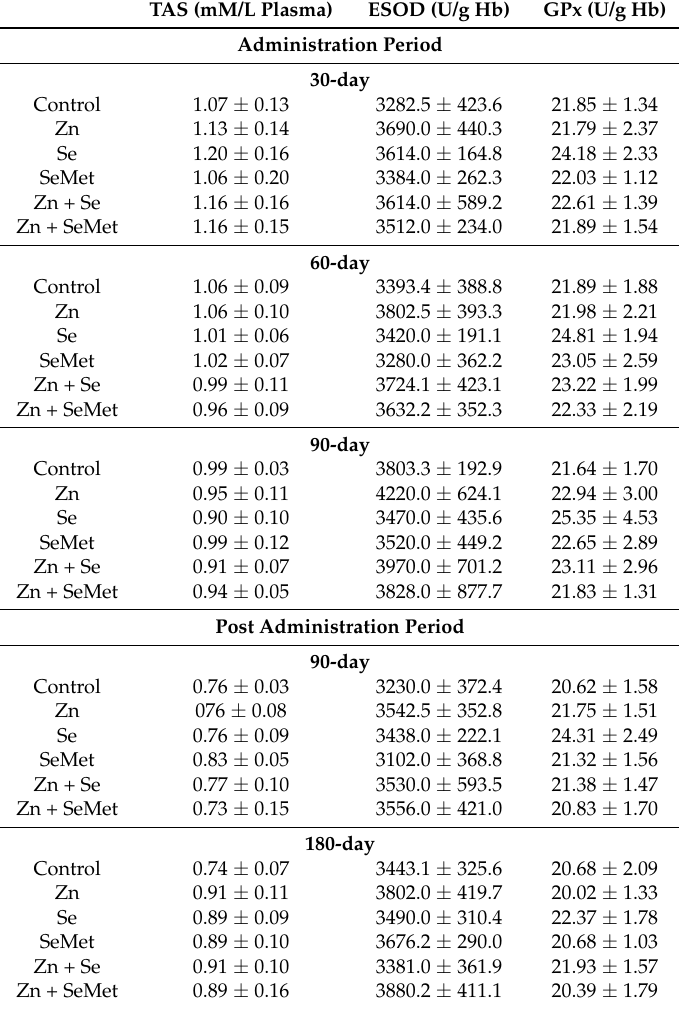
Table 3. Selected biochemical parameters in rats following zinc gluconate (Zn), sodium selenite (Se) and selenomethionine (SeMet) administration given jointly or separately for 30, 60 and 90 days and then after 90 and 180 days